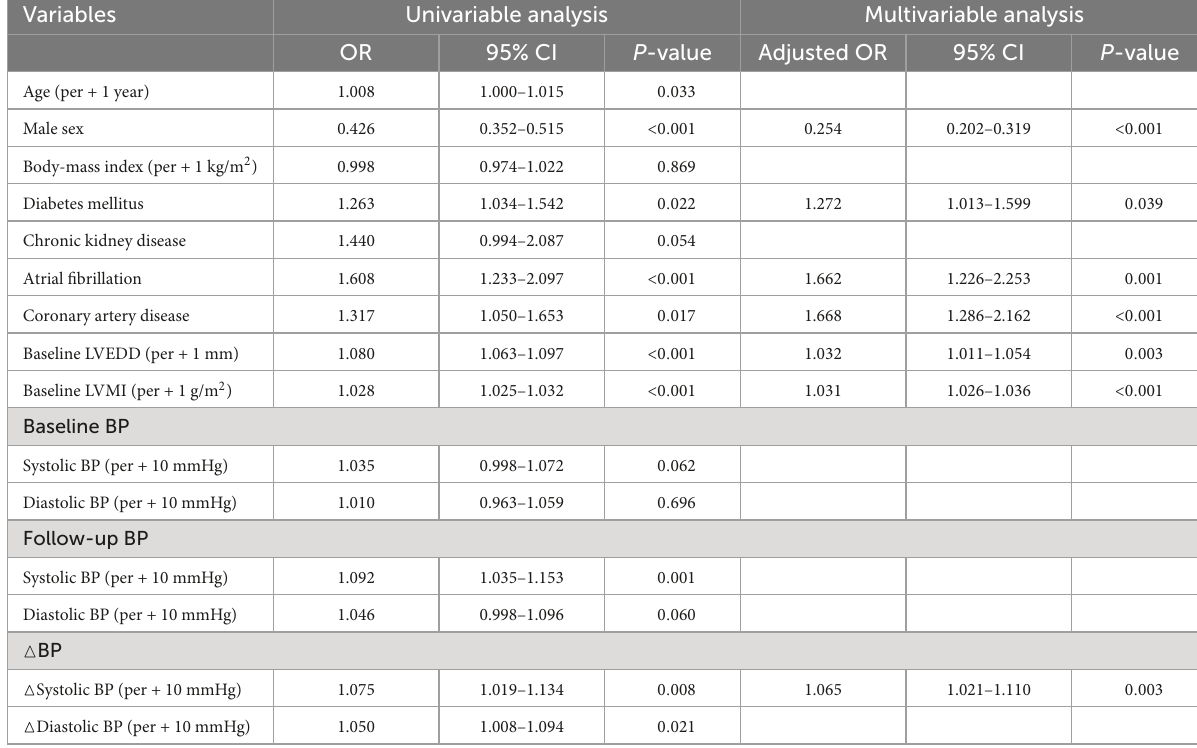
TABLE 3 Predictors of persistent or newly developed